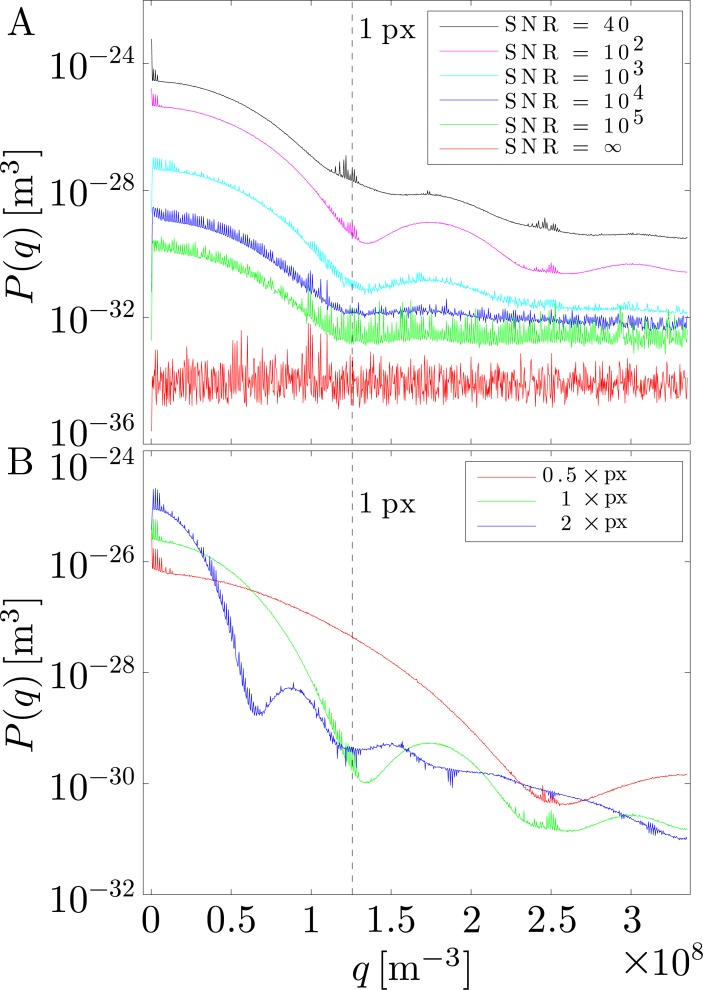
Shape and level of the noise floor depends on the pixel size and SNR.(A) Illustration of the inverse scaling behavior of the spectrum with pixel size. 1 × px corresponds to the experimental pixel size. The shape of the noise floor is the result of the pixel-noise being convoluted with kernel from the linear interpolation. (B) Plot of the spectra obtained for different SNRs. The noise floor decreases for higher (better) SNRs. At high SNRs (SNR ≥ 104) it begins to enter the noise due to numeric imprecision. Since this noise is independent of pixels, spectrum for SNR = ∞ is flat (red line).